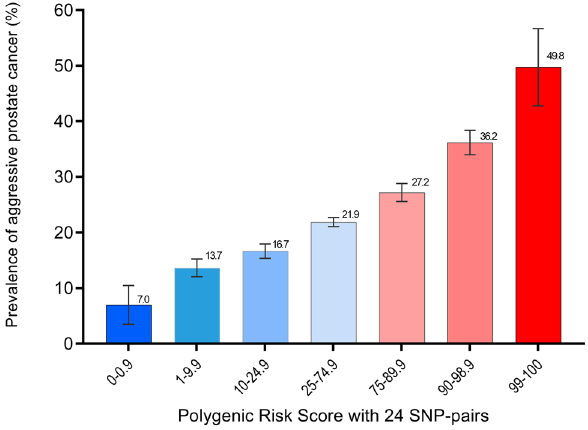
Figure 4. Performance of the polygenic risk score of prostate cancer aggressiveness based on the 24 SNP pairs. PCa prostate cancer, SNP single-nucleotide polymorphism. Mean and 95% confidence intervals of PCa aggressiveness prevalence were